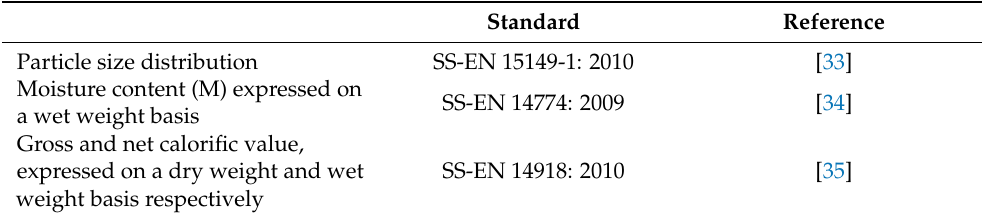
Table 2. Standards used for sampling, sample preparation, classification and determination of fuel characteristics.